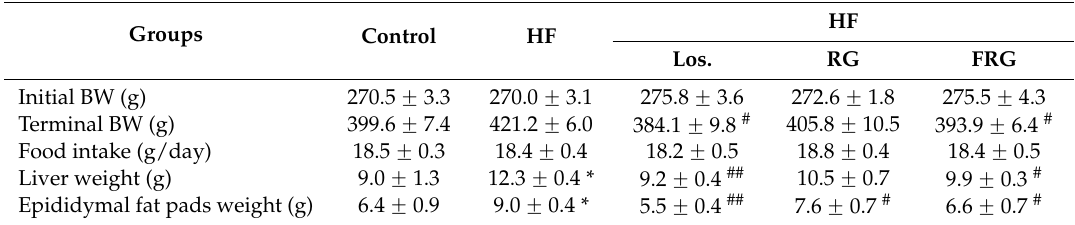
Table 1. Effect of fermented red ginseng FRG on body weight, liver weight and epididymal fat pads. Groups Control HF